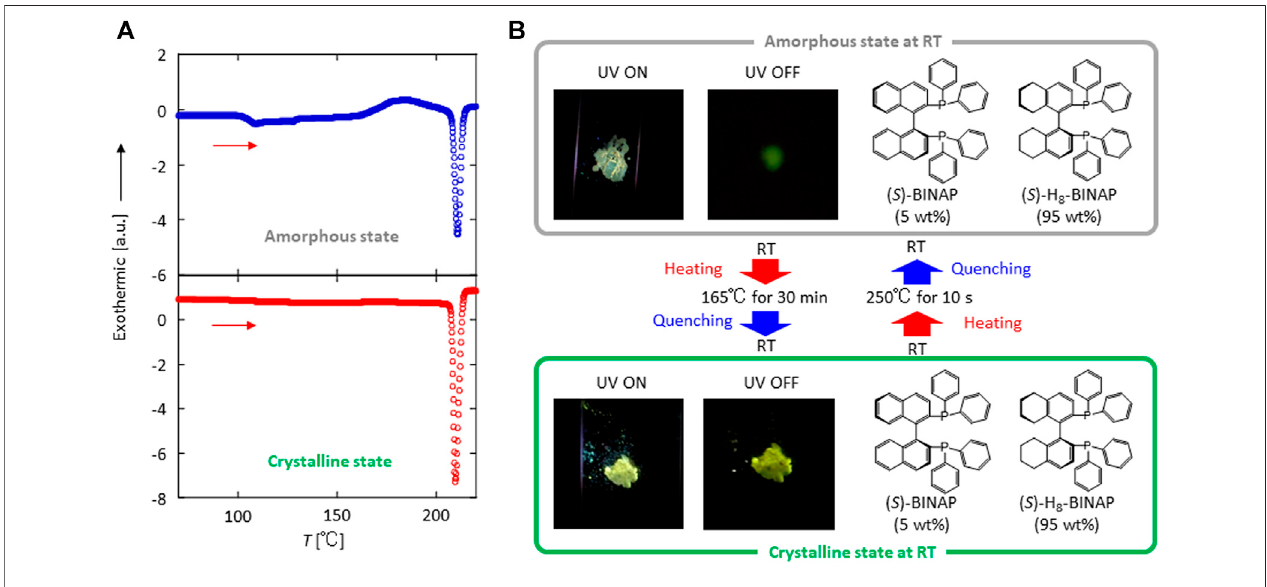
FIGURE 1 | Reversible crystal – amorphous phase change at RT and p RTP characteristics of the ( S )-BINAP doped ( S )-H 8 -BINAP solid. (A) Differential scanning calorimetry characteristics of amorphous state (upper) and crystalline state (lower) when heated at 5 ° C/min. (B) Emission behavior during and immediately after excitation by exposure to radiation (330 nm) of amorphous (upper) and crystalline (lower) solids. (( S )-BINAP (cid:1) ( S )-( − )-2,2 ′ -bis(diphenylphosphino)-1,1 ′ -binaphthyl ( S )- H